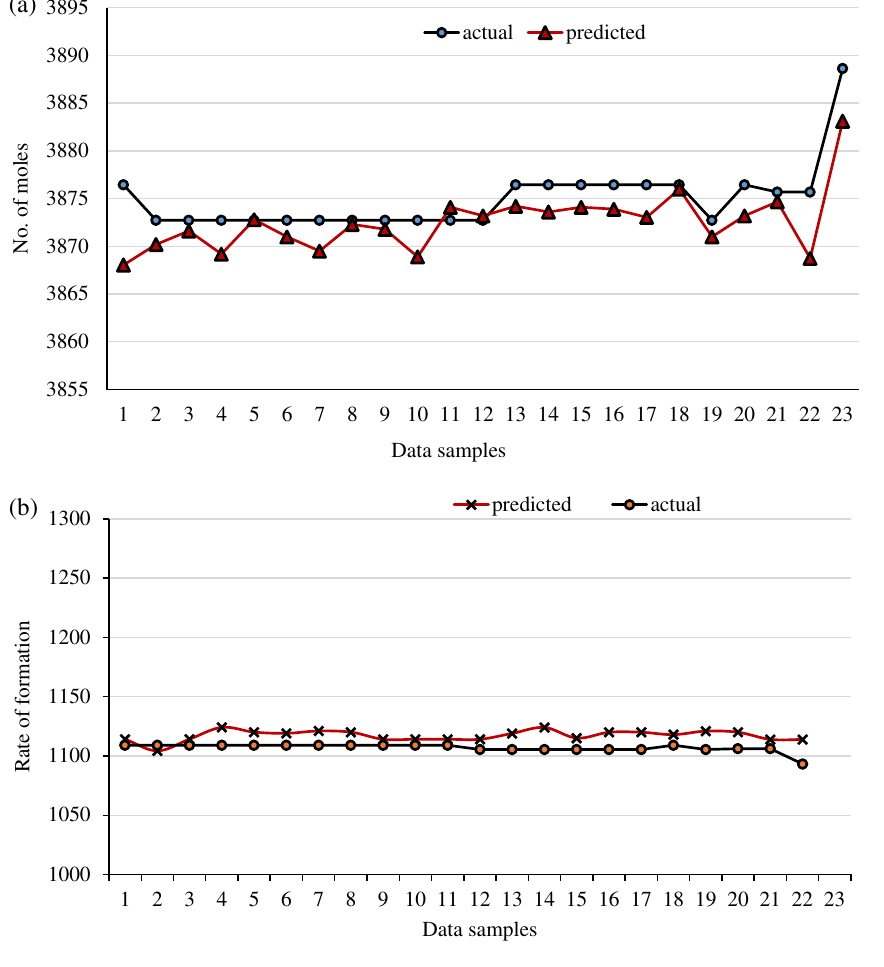
Figure 16. Validation plot for gas + CO 2 + crude